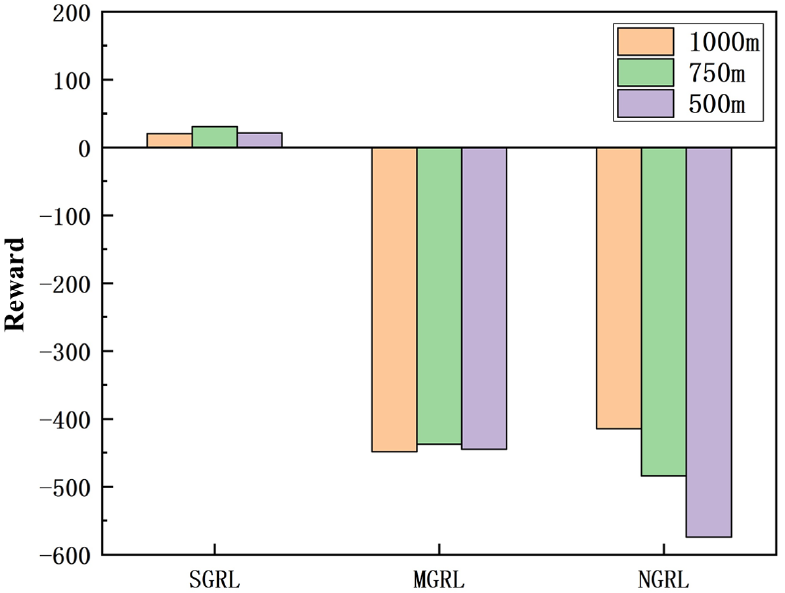
Figure 18. Diagram of testing reward. This value is the average of the total reward value for each episode in the test.